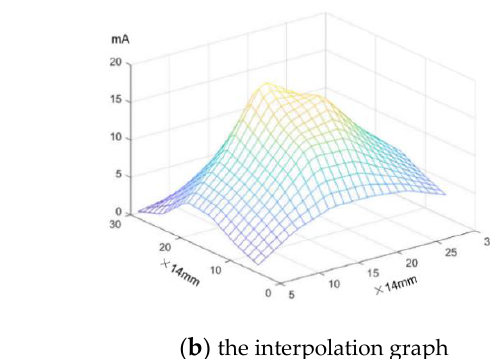
Figure 11. The distribution of current irradiated by the 808 nm laser. Table 5. The voltages and currents of the branch irradiated by the 808 nm laser.